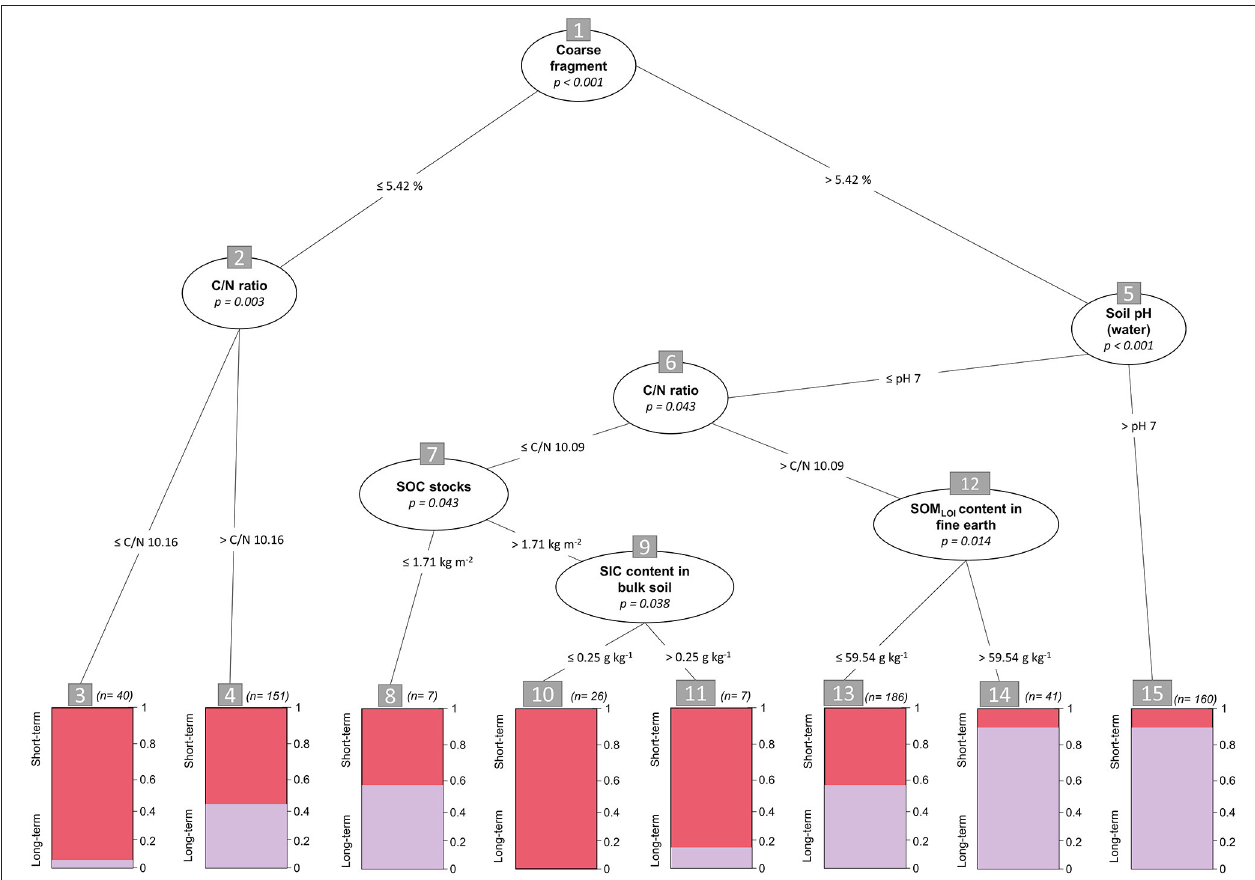
FIGURE 11 | Dendrogram showing the hierarchical alignment of the six variables that can most clearly discriminate short-term and long-term urban soils. Branches show threshold values for the partitioning referring to the variable shown in the node above together with the test statistics for variable selection. Numbers on top of the nodes indicate the hierarchical